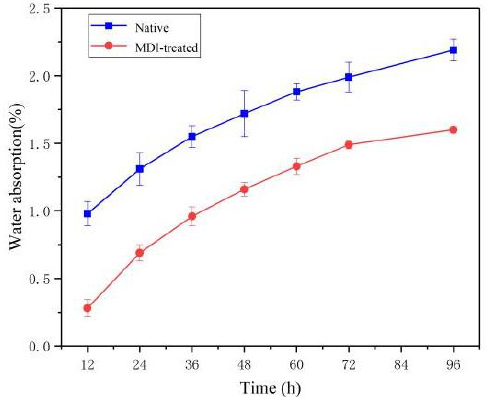
Figure 5. E ff ect of MDI modification on water absorption of 10% cassava residues / polybutylene Figure 5. Effect of MDI modification on water absorption of 10% cassava residues/polybutylene succinate (PBS) biodegradable succinate (PBS) biodegradable composite.